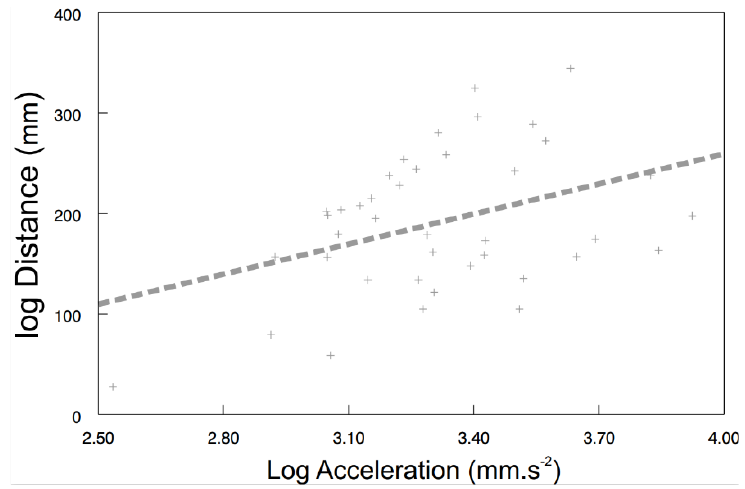
Figure 5. The relationship between distance and acceleration of control shrimps. Predicted values are from a particular LMM model. The curve was fitted by: y = 99.6953x − 139.4662 (r 2 = 0.16).